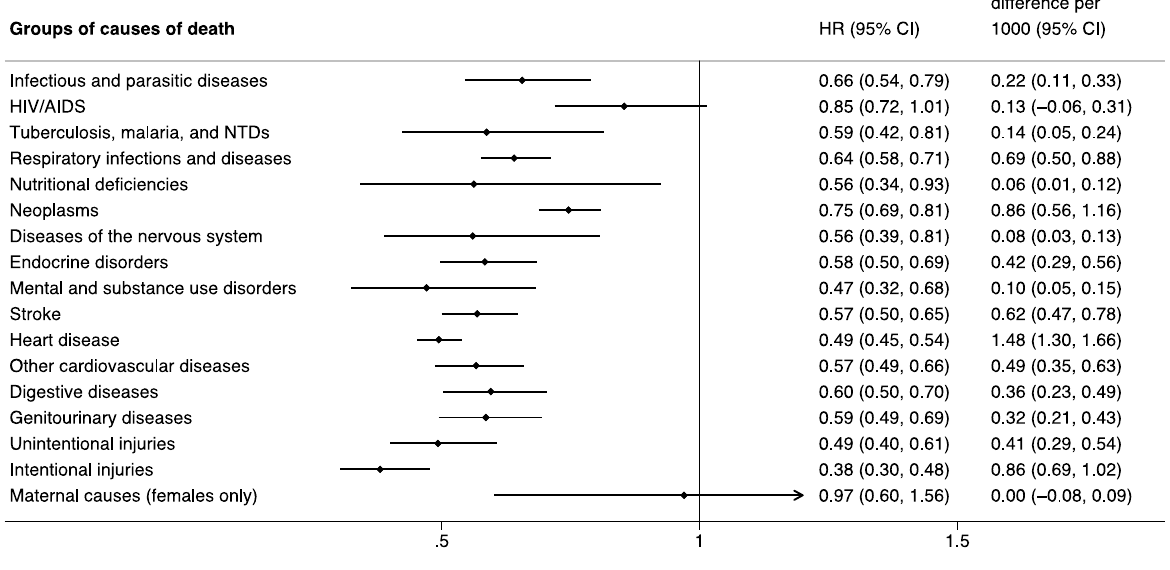
Fig 3. HRs from FHS usage on time until death from selected causes. Estimated HRs obtained from flexible parametric survival models with IPTW and regression adjustment for sex, race/ethnicity, age at cohort entry, highest level of education, disability, unemployment, household per capita income decile, number of family members per bedroom, family size, number of children in family, household flooring, household piped water access, quintiles of household expenditure on medicines, quintile of per capita household expenditure on food, formal labor employment, formal labor employment in the family, whether the family receives Bolsa Familia or not, and whether the individual has been hospitalized before FHS use. A separate model was carried out for each groups of causes. HRs interpreted relative to a mean time since FHS usage of 2.6 years. Infectious and parasitic diseases exclude HIV/AIDs, tuberculosis, malaria, and NTDs. FHS, Family Health Strategy; HR, hazard ratio; IPTW, inverse probability treatment weighting; NTD, neglected tropical disease.